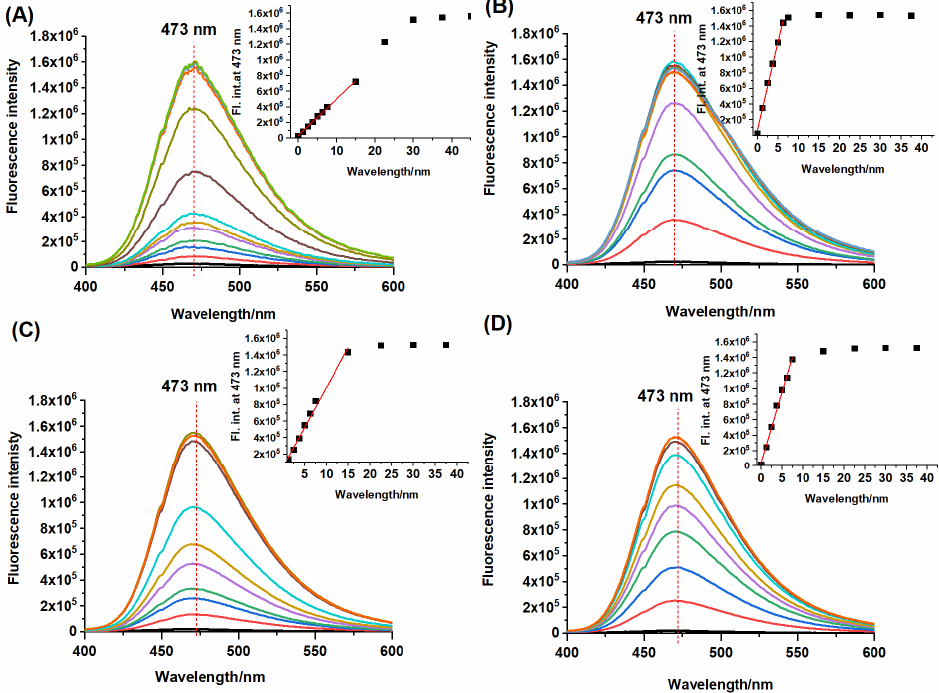
Figure 6. Emission spectra of probe NBD-O-CmCH 2 OH (7.5 µ M) in the presence of various concen- trations of ( A ) Na 2 S (0–45 µ M), ( B ) L-Cys (0–37.5 µ M), ( C ) GSH (0–37.5 µ M), ( D ) NAC (0–37.5 µ M) in phosphate buffer (0.1 M, pH 7.4, with 10% MeCN, v/v ). Spectra were recorded after 10 min of incubation at room temperature.